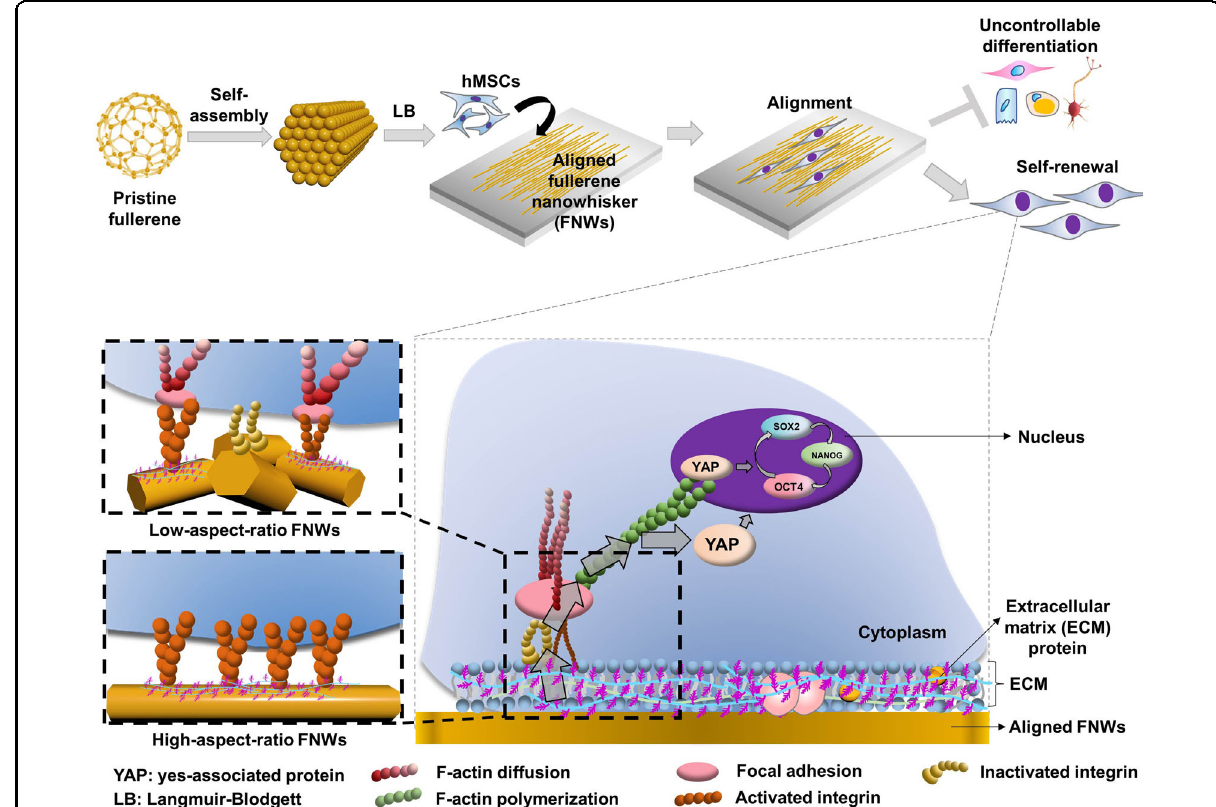
Fig. 6 Surface modi fi cation with a fullerene nanowhisker and its plausible interaction with human mesenchymal stem cells. Highly alligned fullerene nanowhisker nanopatterned surfaced mediated by nucleus localization of Yes-associated protein and suitable cell contractility able to regulate regenerative capacity of human mesenchymal stem cells